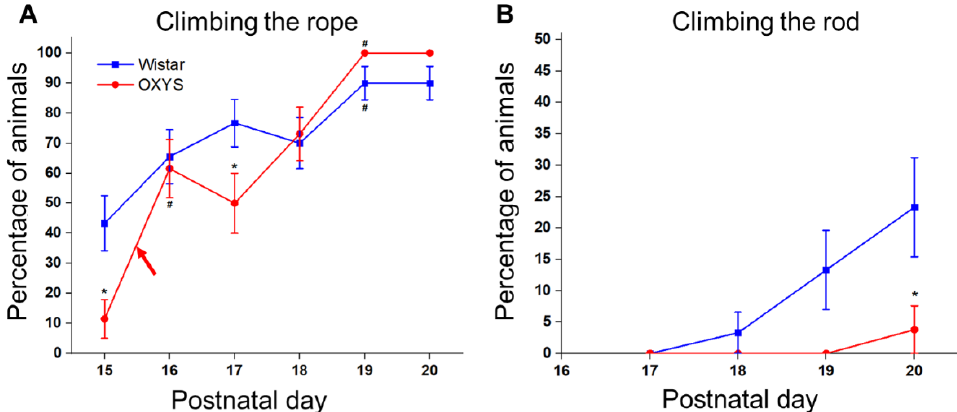
Figure 7. The abilities of OXYS and Wistar pups to climb the rope and rod. ( A ) Climbing the rope; ( B ) climbing the rod. * p < 0.05 as compared to control (Wistar) rats; # p < 0.05 as compared to a previous day; red arrow: eye opening in OXYS pups. The data are presented as the mean ± SEM. Thus, overall, the abilities to climb up and down arose later in OXYS pups than in Wistar pups.